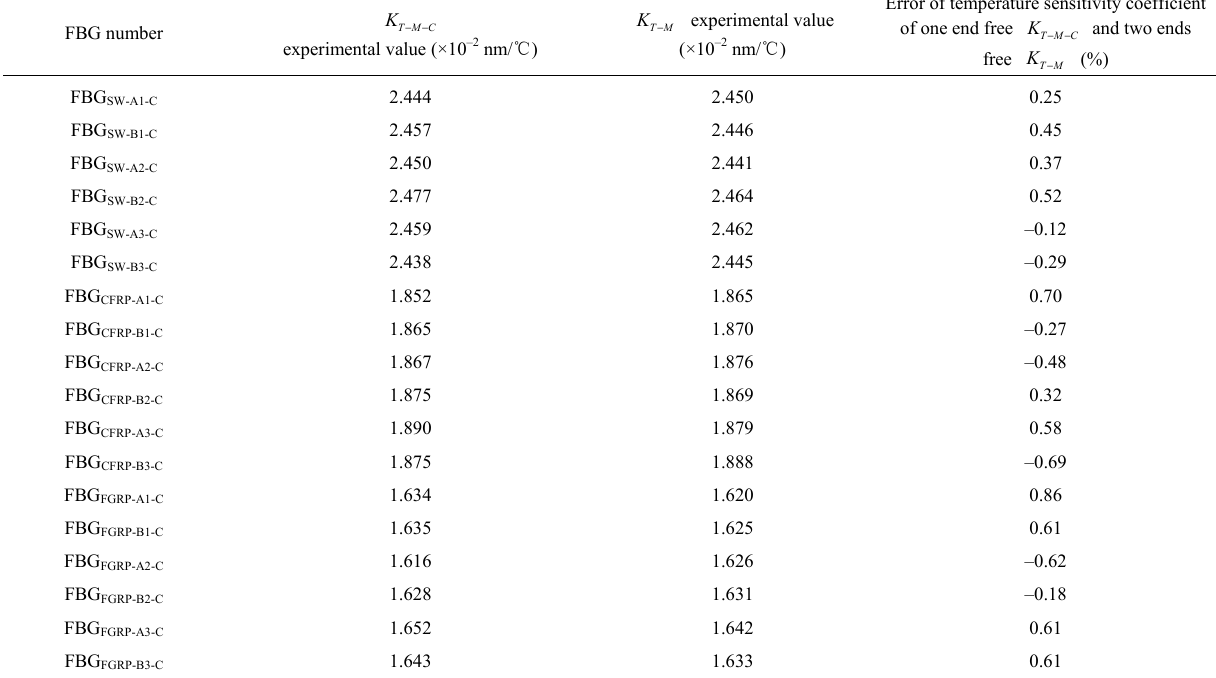
and ) for one free end and two free K K - - - T M C T M